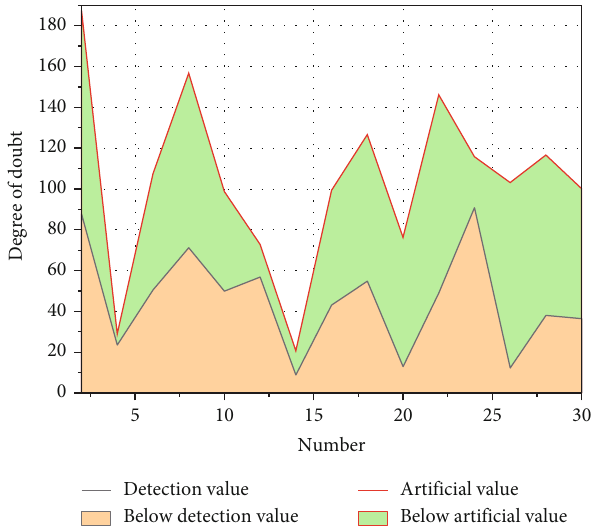
Figure 7: Comparison of Doubt Levels.